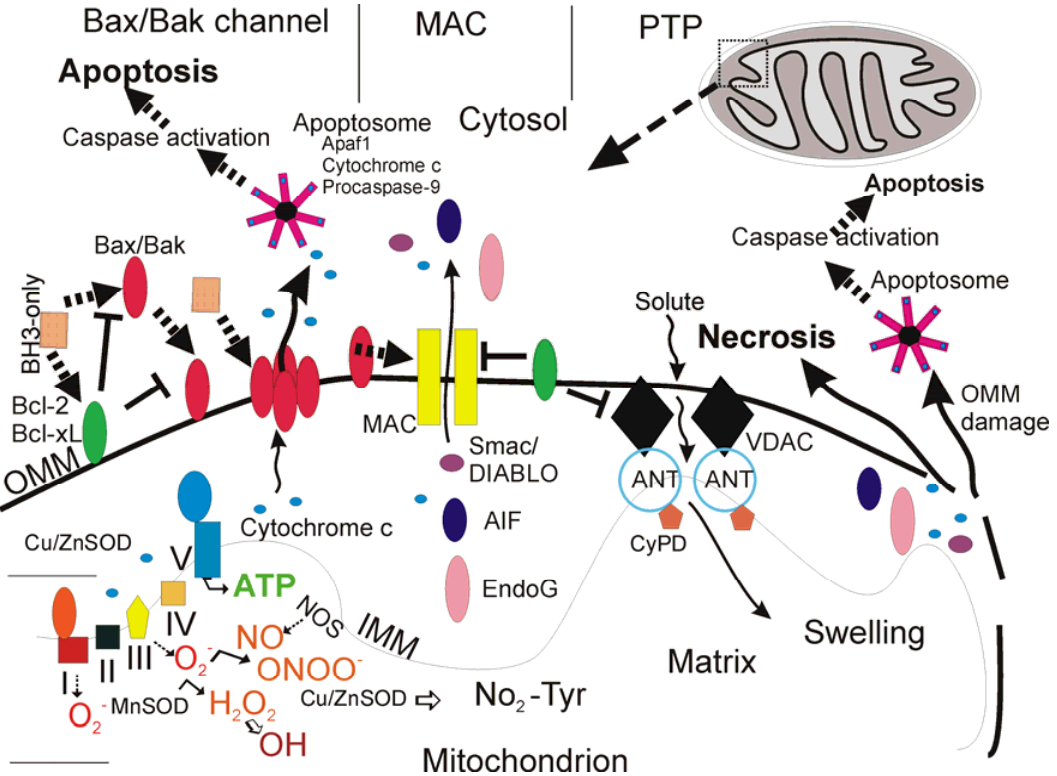
Figure 1. Mitochondria (upper right) are multi-functional organelles and regulate neuronal cell life and death (adapted from an earlier form [5]). See text for